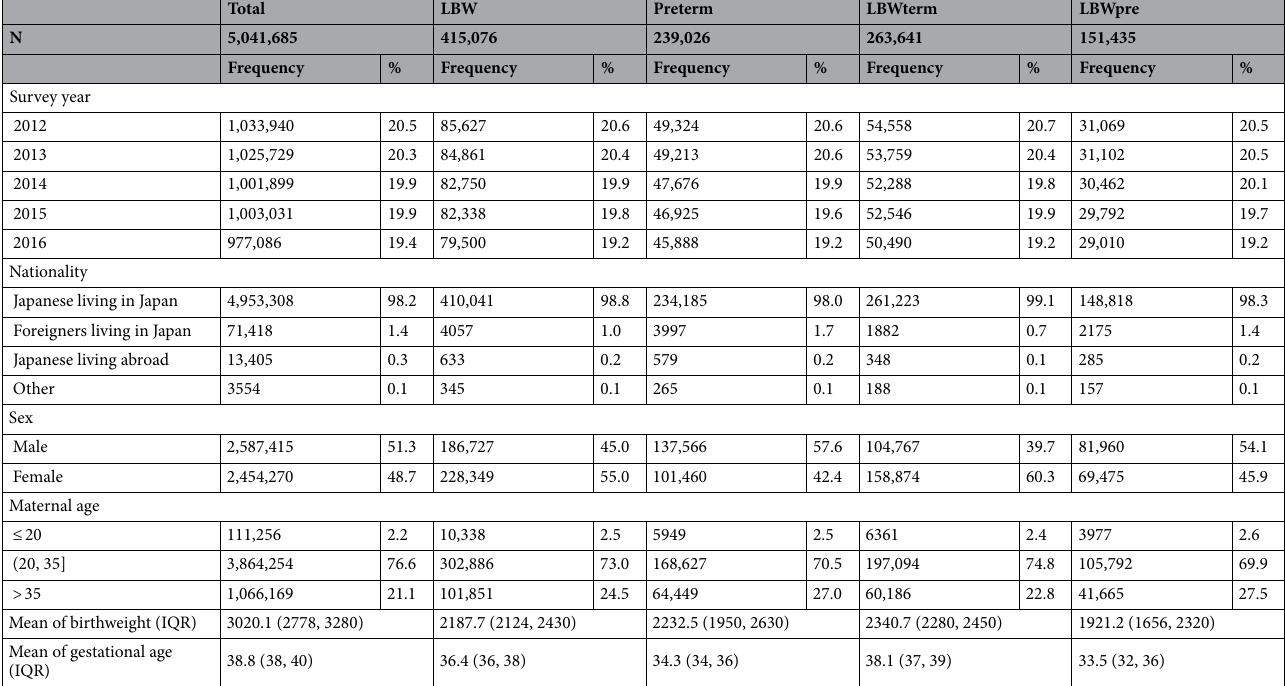
Table 1. Basic characteristics of LBW, Preterm, and LBWterm, and LBWpre. IQR inter quantile